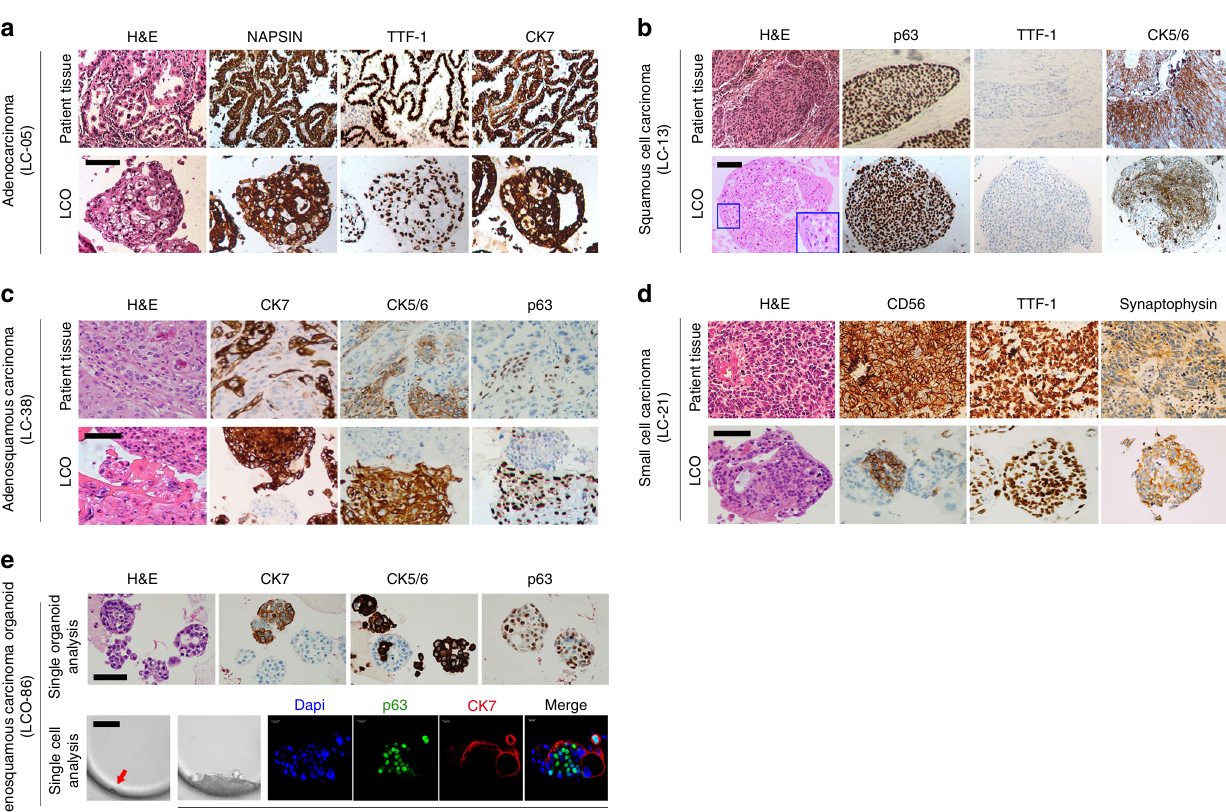
Fig. 2 LCOs recapitulate the characteristics of the original tissues. a – d H&E-stained and IHC-stained images of LCOs and their original LC tissues. The enlarged images in blue boxes of b showed cytoplasmic keratinisation of individual squamous carcinoma cells. Scale bars, 100 μ m. e H&E and IHC-stained images of an adenosquamous carcinoma organoid (upper panel). Individual organoids expressed either adenocarcinoma marker (CK7) or squamous cell carcinoma markers (CK5/6 or p63). Some single organoids showed mixed cell pattern composed of CK7 + and CK7 − cells, CK5/6 + and CK5/6 − cells, and p63 + and p63 − cells. Scale bar, 100 μ m. Bright fi eld microscopy and immuno fl uorescence (IF) images of an adenosqumaous carcinoma organoid originated from a single cell (lower panel). The immuno fl uorescence staining was performed at Day 18 after seeding. The organoid from a single cell was composed of p63 + /CK7 − cells and p63 − /CK7 + cells. The red arrow indicated a single cell seeded in a micro-well. Scale bar in bright- fi eld microscopy images, 100 μ m. Scale bar in IF images, 20 μ